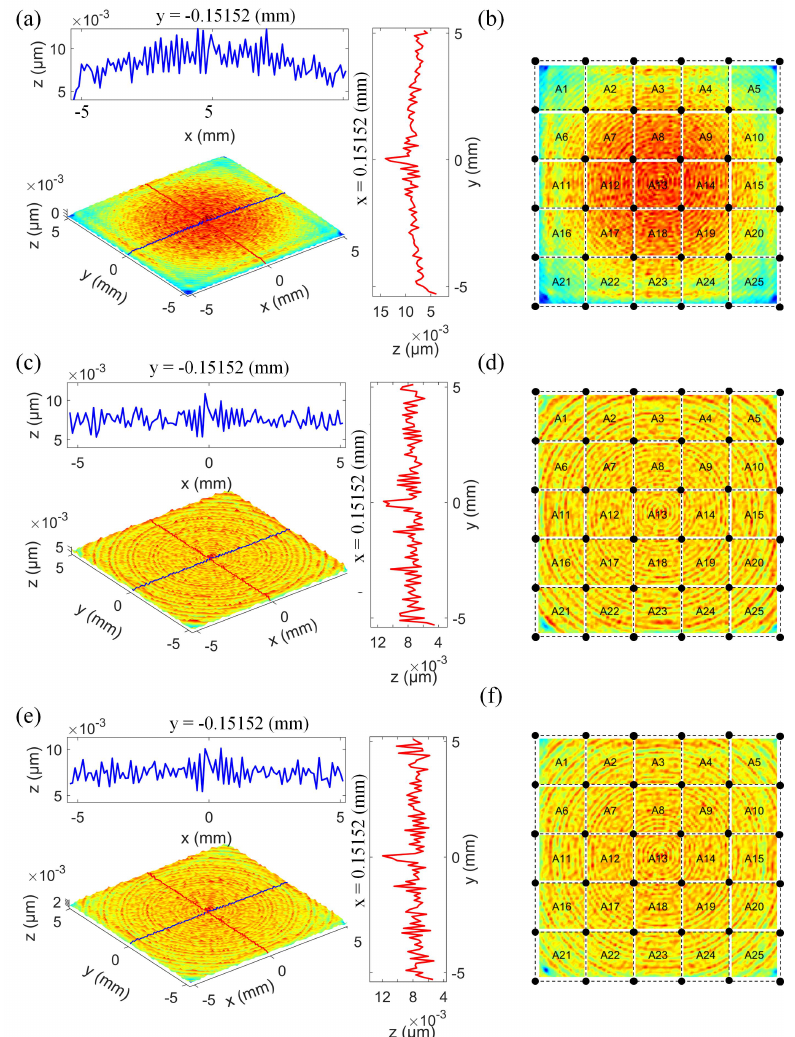
Figure 10. Residual error of the concerned surface region polished along: ( a , b ) the unoptimized path; ( c , d ) the RMS-map-based optimized path; and ( e , f ) the PV-map-based optimized path.